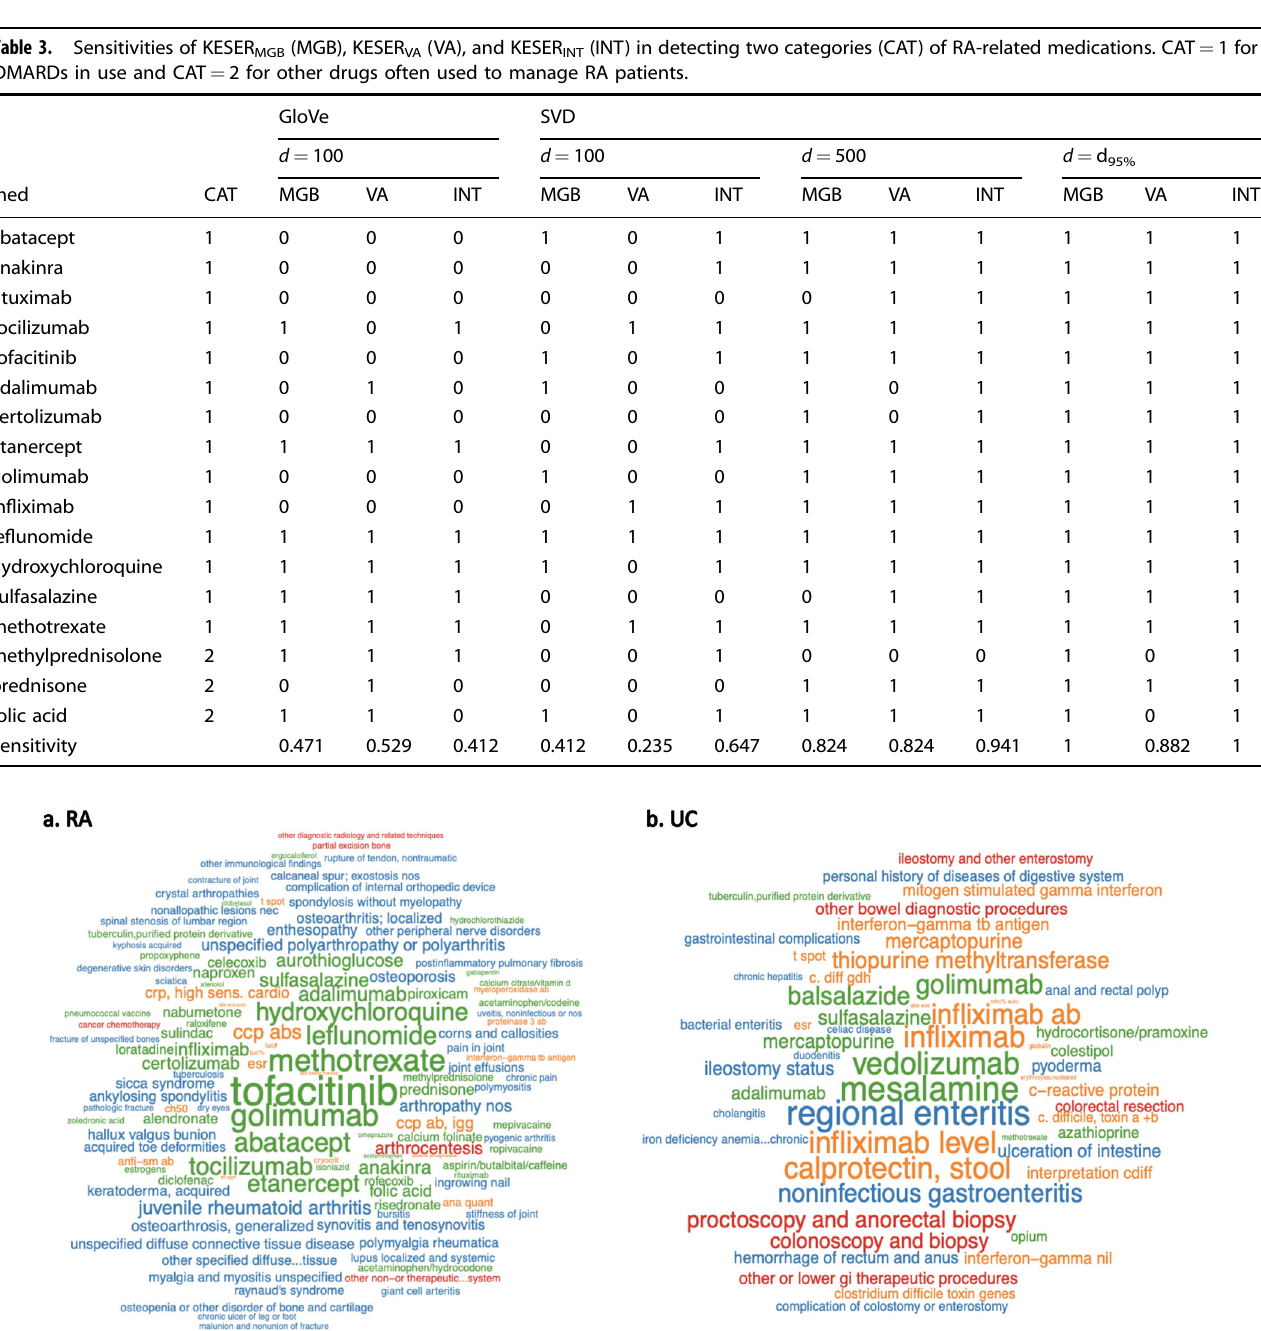
Fig. 2 Word cloud for KESER MGB selected features. ( a ) Selected features for Rheumatoid Arthritis (RA); ( b ) selected features for Ulcerative Colitis (UC). The size of the words is proportional to the absolute coef fi cients from the embedding